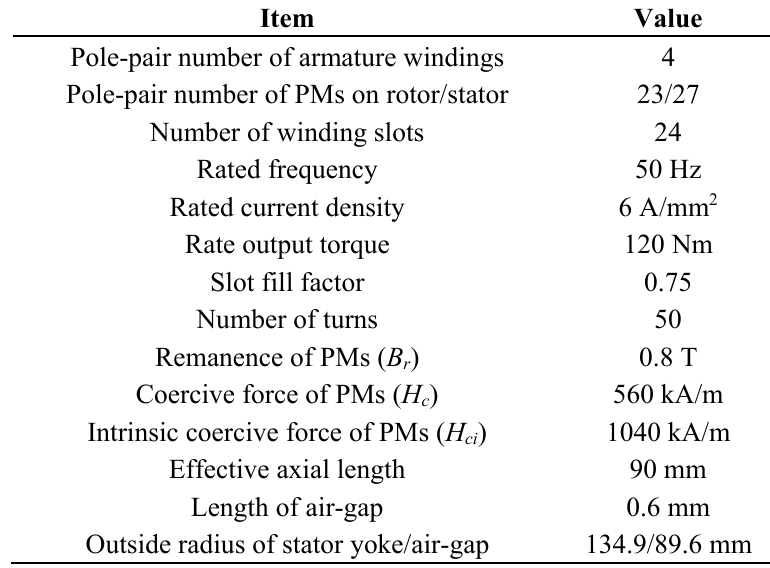
Figure 1. Dual-permanent-magnet-excited (DPME) machine and its design variables. Table 1. Specifications of investigated Dual-permanent-magnet-excited (DPME)